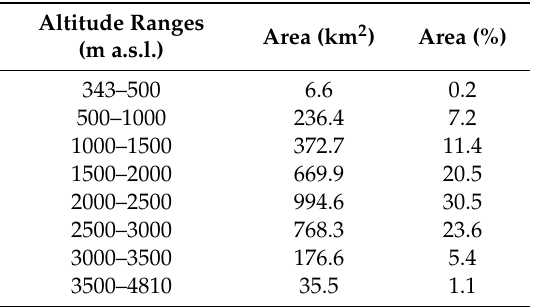
Table 1. Aosta Valley altitude ranges and correspondent areas.